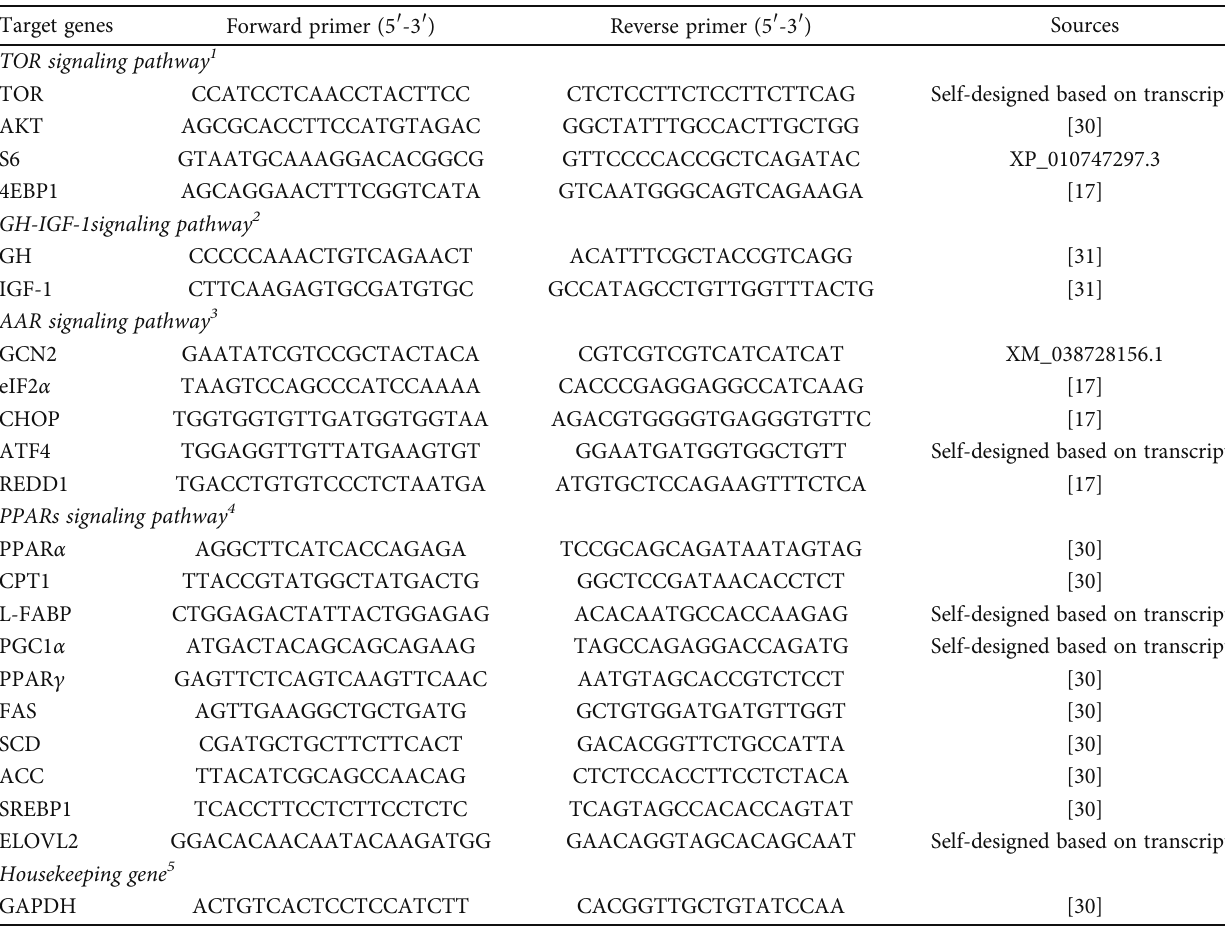
Table 4: Real-time PCR primer sequences used in the present